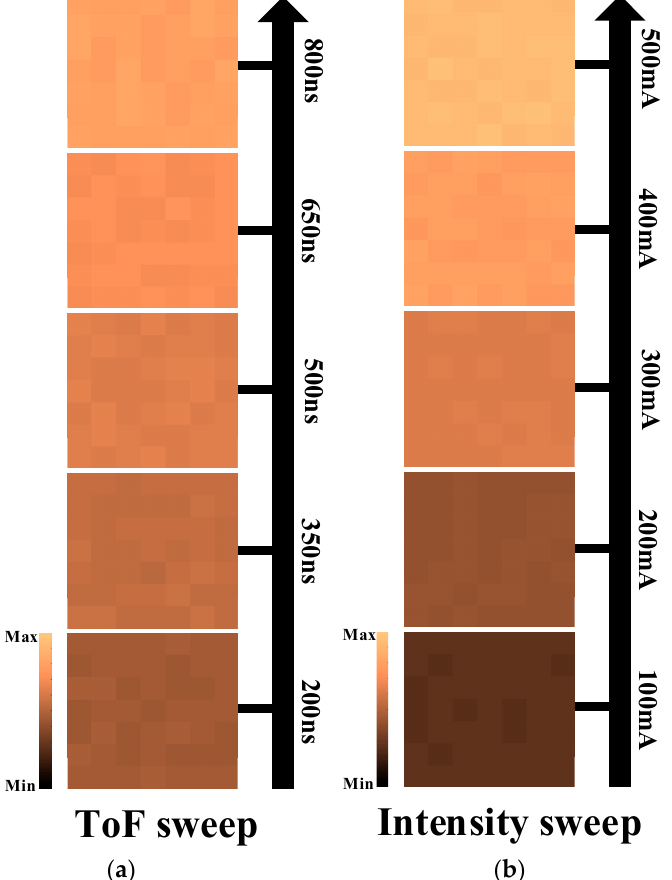
Figure 13. Captured sample images taken from the prototype chip: ( a ) range images with ToF sweep and ( b ) intensity images with laser power sweep.